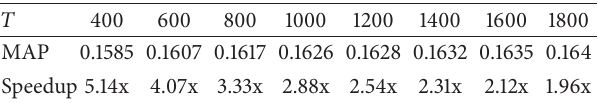
Table 3: MAP and speedup variations with T on Corel 10 K ( 𝐻 = 3, 𝑆 = 300 ). 𝑇 400